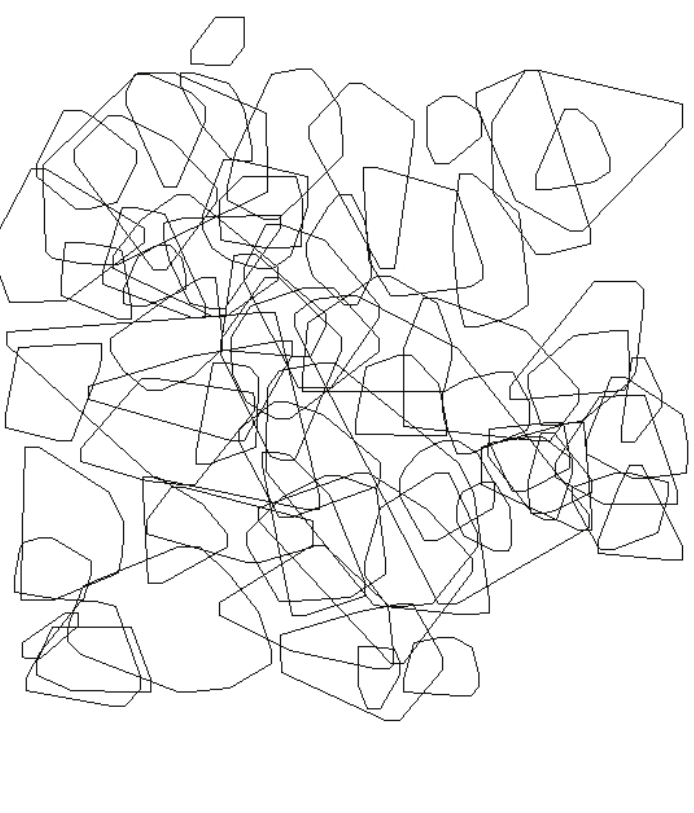
Figure 3. The minimum convex polygon 85% peeled ranges for all adult males with $ 6 sightings.